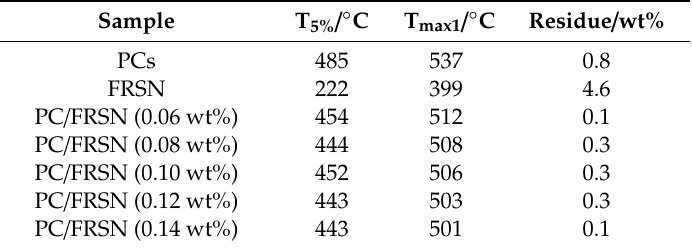
Table 3. TGA results of PC composites, neat PC and FRSN under air